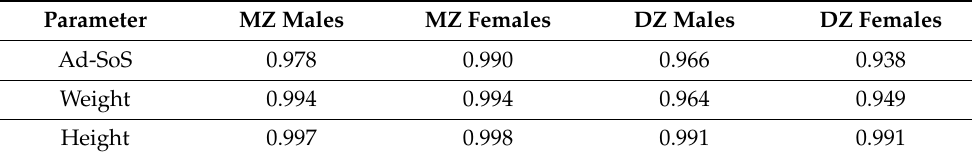
Table 3. Intrapair correlations for the MZ and DZ twins.